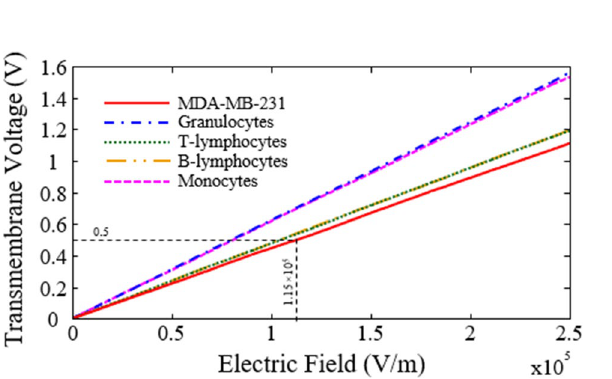
Figure 6. Transmembrane voltage for MDA-MB-231 and different subtypes of WBCs as a function of frequency. Parameter values used in the calculations are given in Table 1.